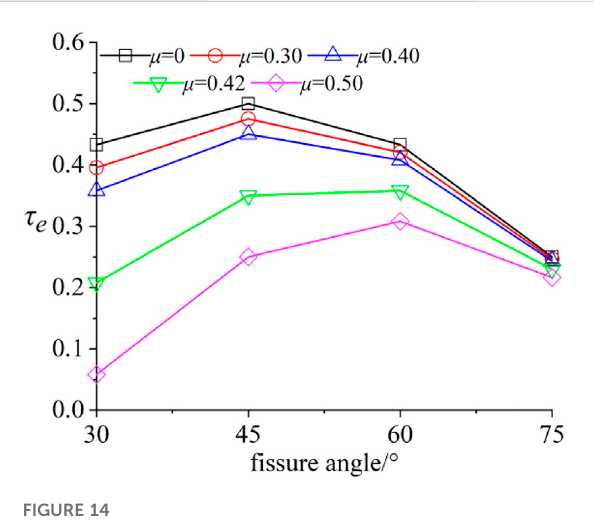
FIGURE 14 The relation between τ e and α under different friction coef fi cients μ